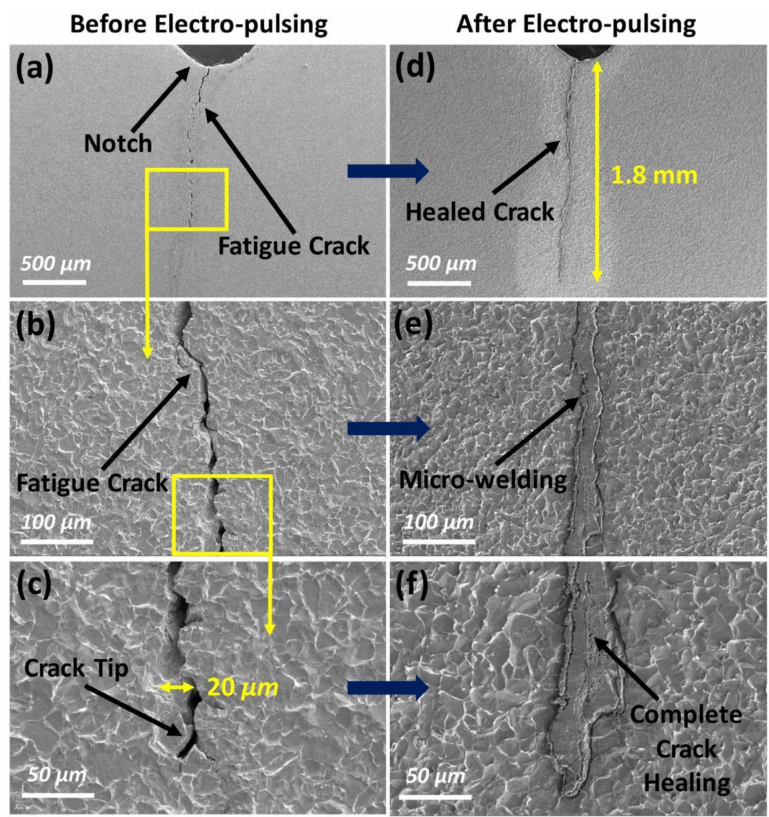
Figure 13. SEM micrograph of crack before and after the application of pulsed electric current (Adapted with permission from Elsevier